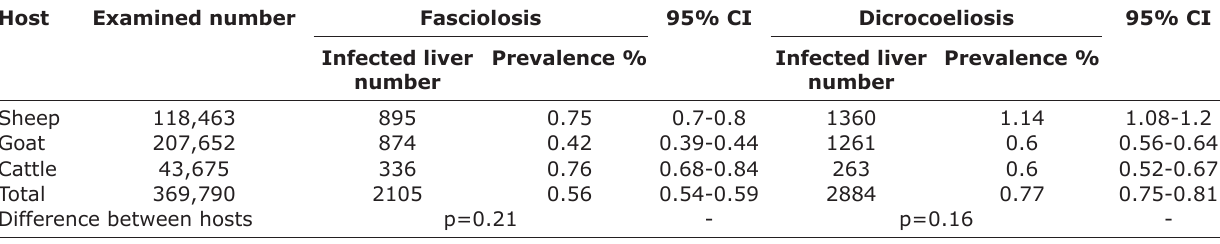
Table-1: The prevalence of condemned livers resulting from Fasciola hepatica, Fasciola gigantica , and Dicrocoelium dendriticum at slaughterhouses of Arak, Iran.